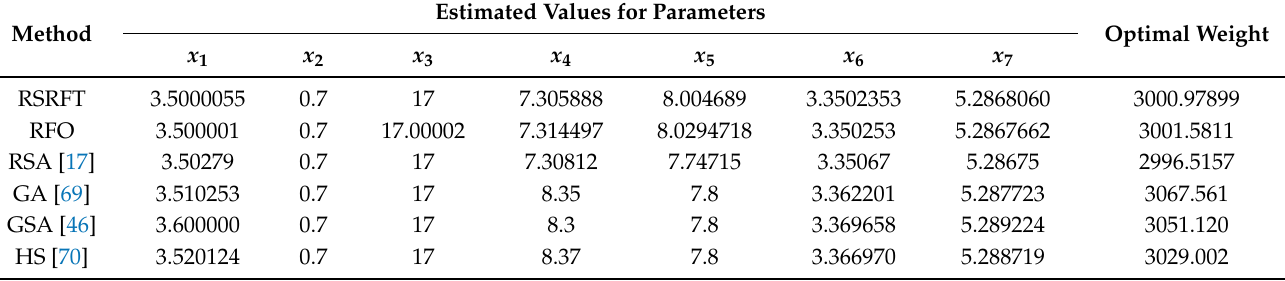
Table 5. The value of the estimated parameters using RSRFT to solve the speed reducer design